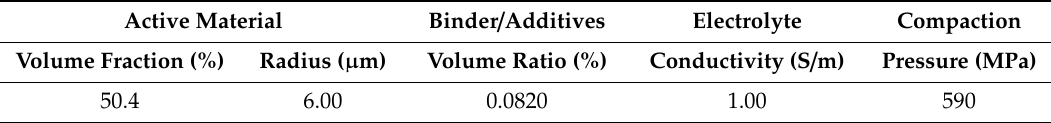
Table 5. Optimized process parameters for the total specific